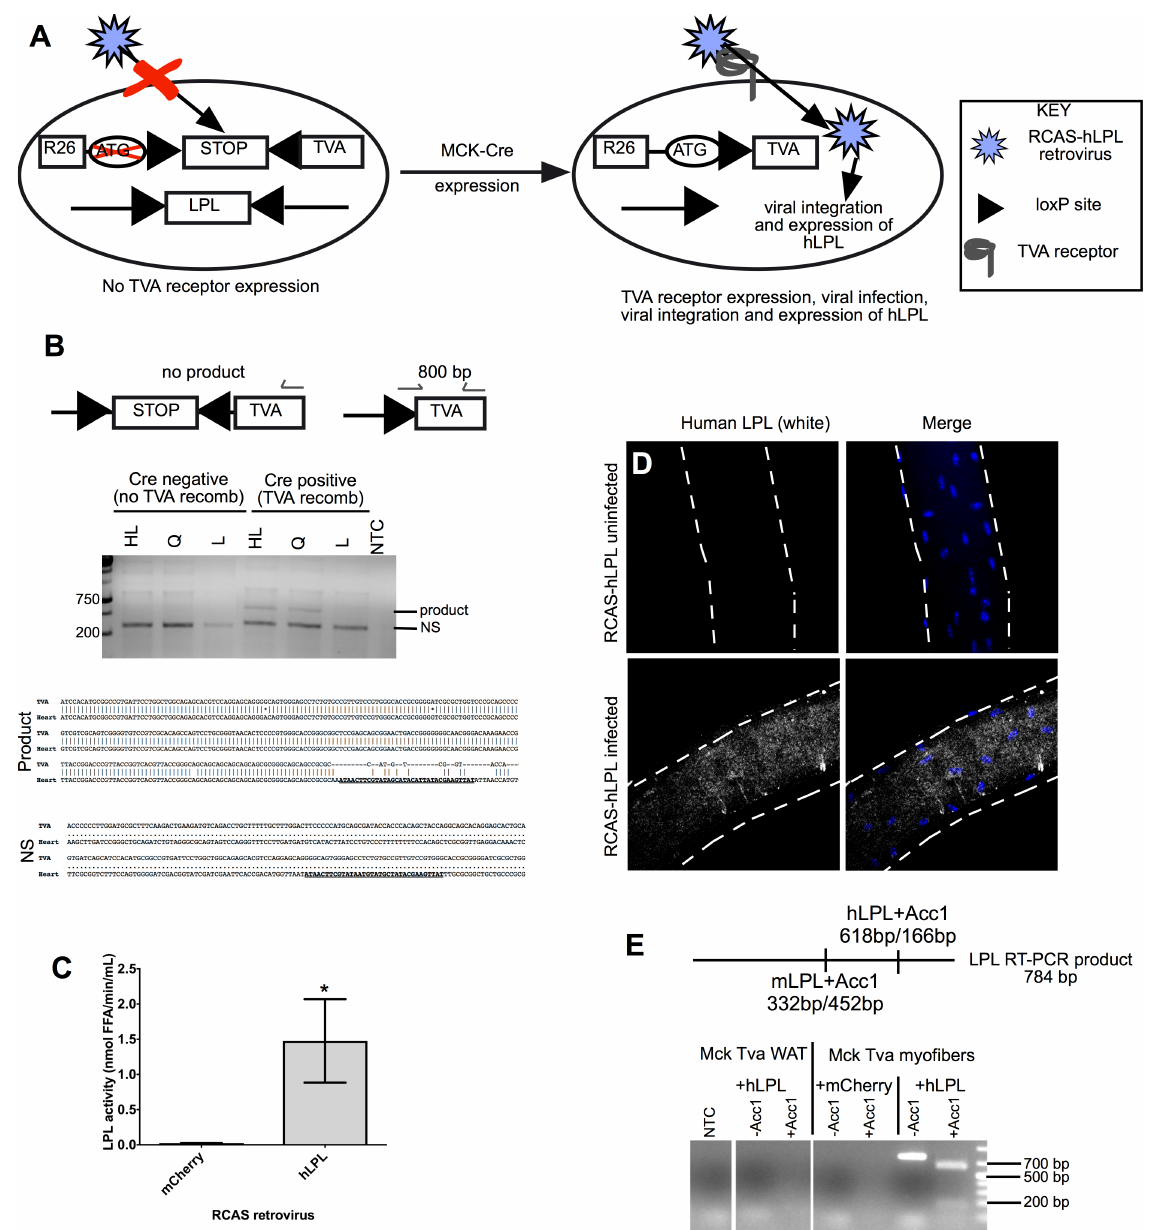
Fig 2. RCAS retroviral infection, integration and expression in vitro . A. An illustrationof Mck-Cre-mediatedrecombination of the Rosa26locus and LPL conditionalallelein mck-Cre;lpl -/- ;Rosa26 LSLTVA lacZ+/- mice. Cre-mediated recombination deletesLPL and enablesTva expressionin striated muscle. Tva expressionis requiredfor RCAS retroviral infection, integrationand expression in striated muscle. B. (Upper) A diagramof PCR primer bindingsites in Rosa26 LSLTVA lacZ+/- allelefor assessingCre-mediated recombination efficiency. (Middle)An 800 bp PCR product is present in muscles of mck-Cre;Rosa26 LSLTVA lacZ+/- mice but not in liver tissue. The 800 bp PCR product is detectablein hindlimb(HL) and quadriceps (Q) of mck-Cre; Rosa26 LSLTVA lacZ+/- mice. A PCR product is not detectablein in liver (L) demonstrating specificity of Cre-mediated recombination. NS denotesa non-specific product at 400 bp. NTC denotesnon-templatecontrol. (Lower) Representative sequencing alignmentsof the TVA gene and the sequencing product as well as the non-specific product (NS) obtainedfrom heart gDNA PCR products excised from an agarosegel. LoxP sequencesare bold and underlinedin each sample. N = 3 for each condition; representative gel image and sequencing alignment shown. C. Active LPL enzyme is secreted from chicken fibroblast cells (DF1) transfected with RCAS plasmidencoding hLPL. No LPL enzyme activity is detected in media from DF1 cells transfected with RCAS plasmidencoding mCherry (p < 0.003; Student’s t-test). Error bars represent SD. FFA = free fatty acids. N = 3 for each condition.D. Immunofluorescence images of myofibers isolated from mck-Cre;lpl -/- ;Rosa26 LSLTVAlacZ+/- mice 72 hours post-infection in vitro with RCAS-hLPL and